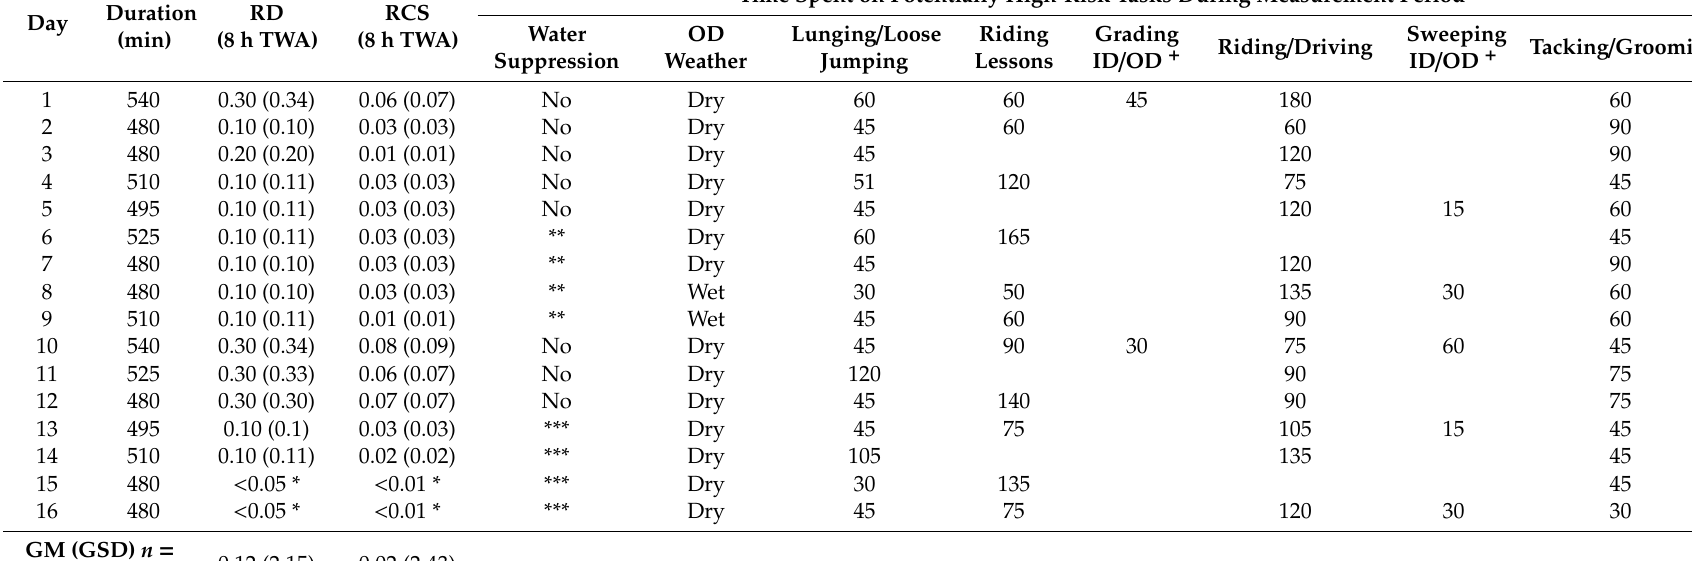
Table 1. Summary of personal respirable dust (RD) and respirable crystalline silica (RCS) concentration data (mg m − 3 ), adjusted 8 h TWA and time (mins) spent on potentially high-risk exposure